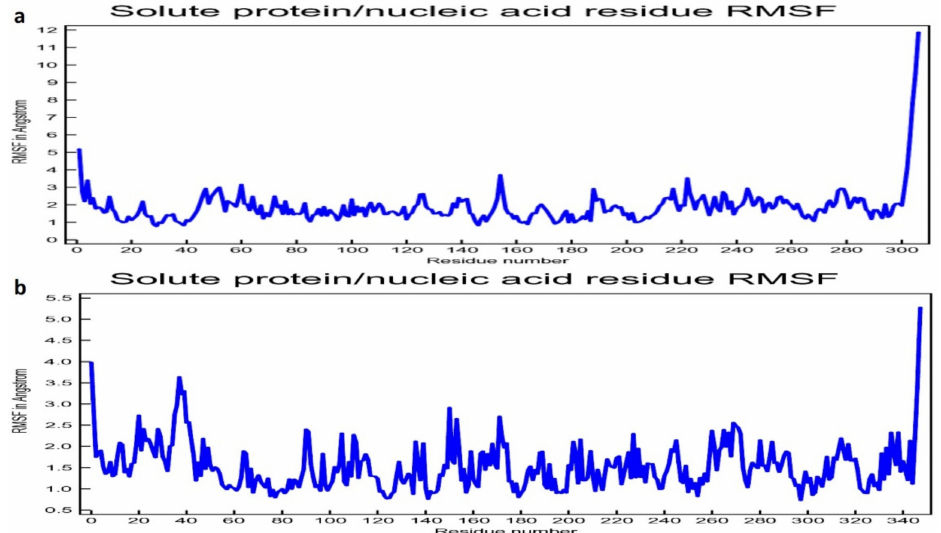
Figure 5. Root mean square fluctuation (RMSF) per solute protein residue for ( a ) DTQ-3CLpro complex ( b ) DTQ-NSP15